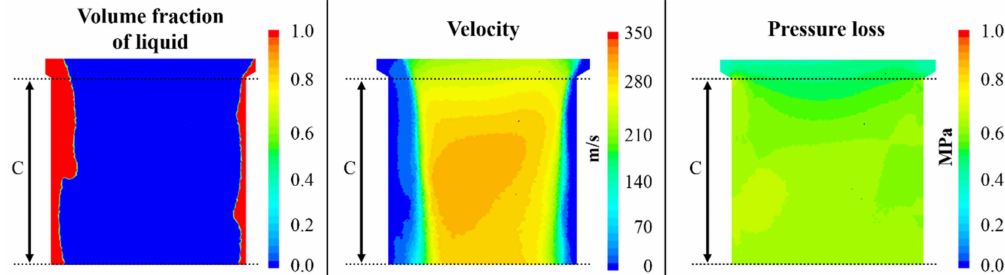
Figure 11. Profiles of the volume fraction of liquid ( left ), velocity ( middle ) and pressure loss in the atomizer ( right ) at µ = 0.12 Pa · s and ALR = 0.15 (Q L = 30 L · h − 1 ; p gas = 0.6